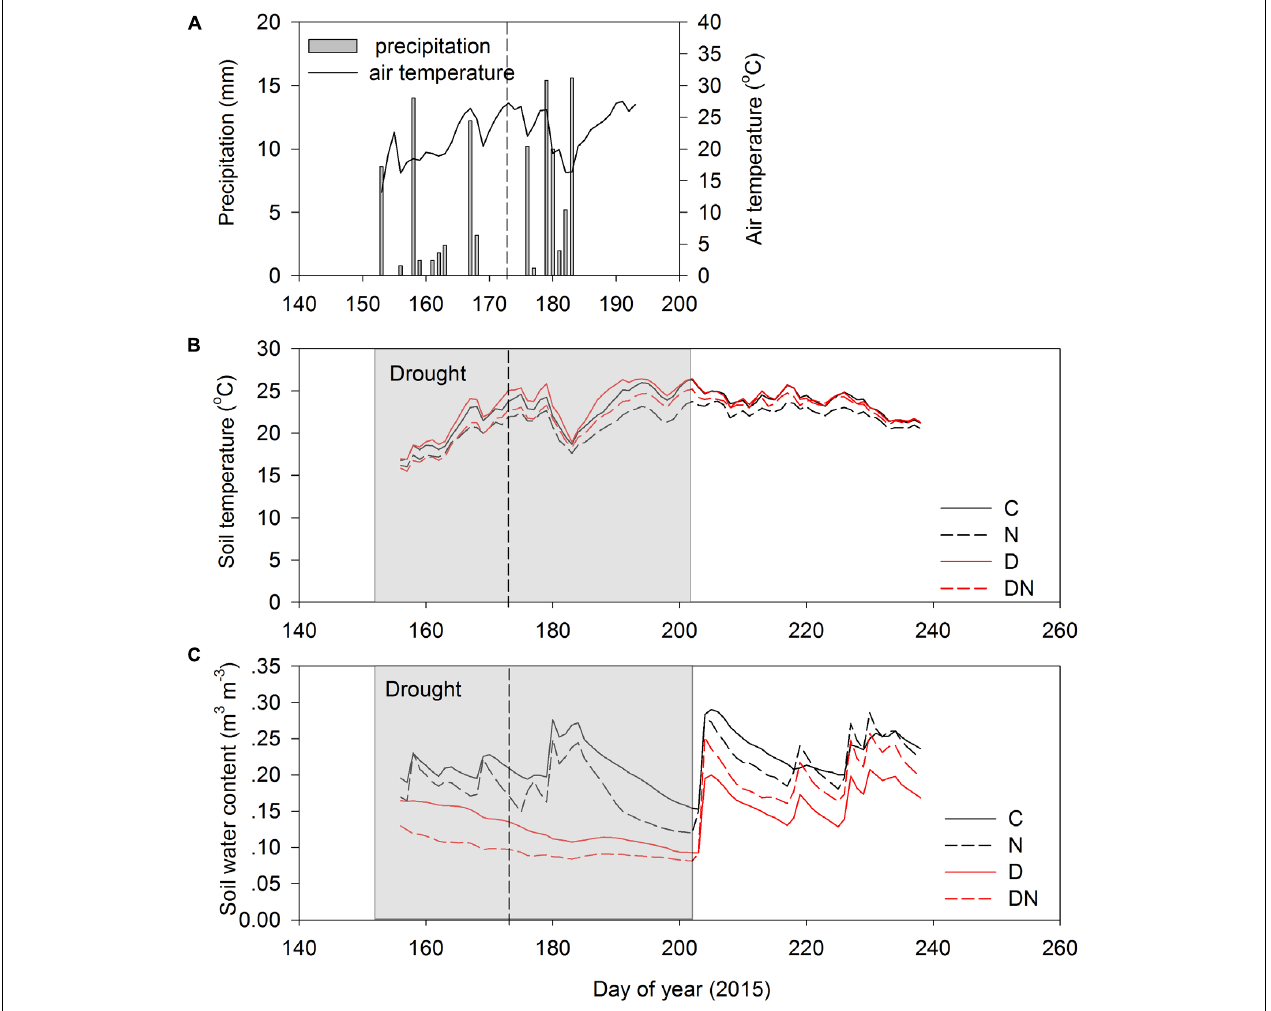
FIGURE 1 | Precipitation (A) , soil temperature (0–10 cm depth) (B) , and soil water content (0–10 depth) (C) for four treatments (C, control; N, nitrogen addition; D, drought; DN, nitrogen addition plus drought) during the growing season in 2015. Shaded area indicates a 51 days extreme drought event (DOY 152 to DOY 202). Vertical dashed lines indicate the middle of the drought period (DOY